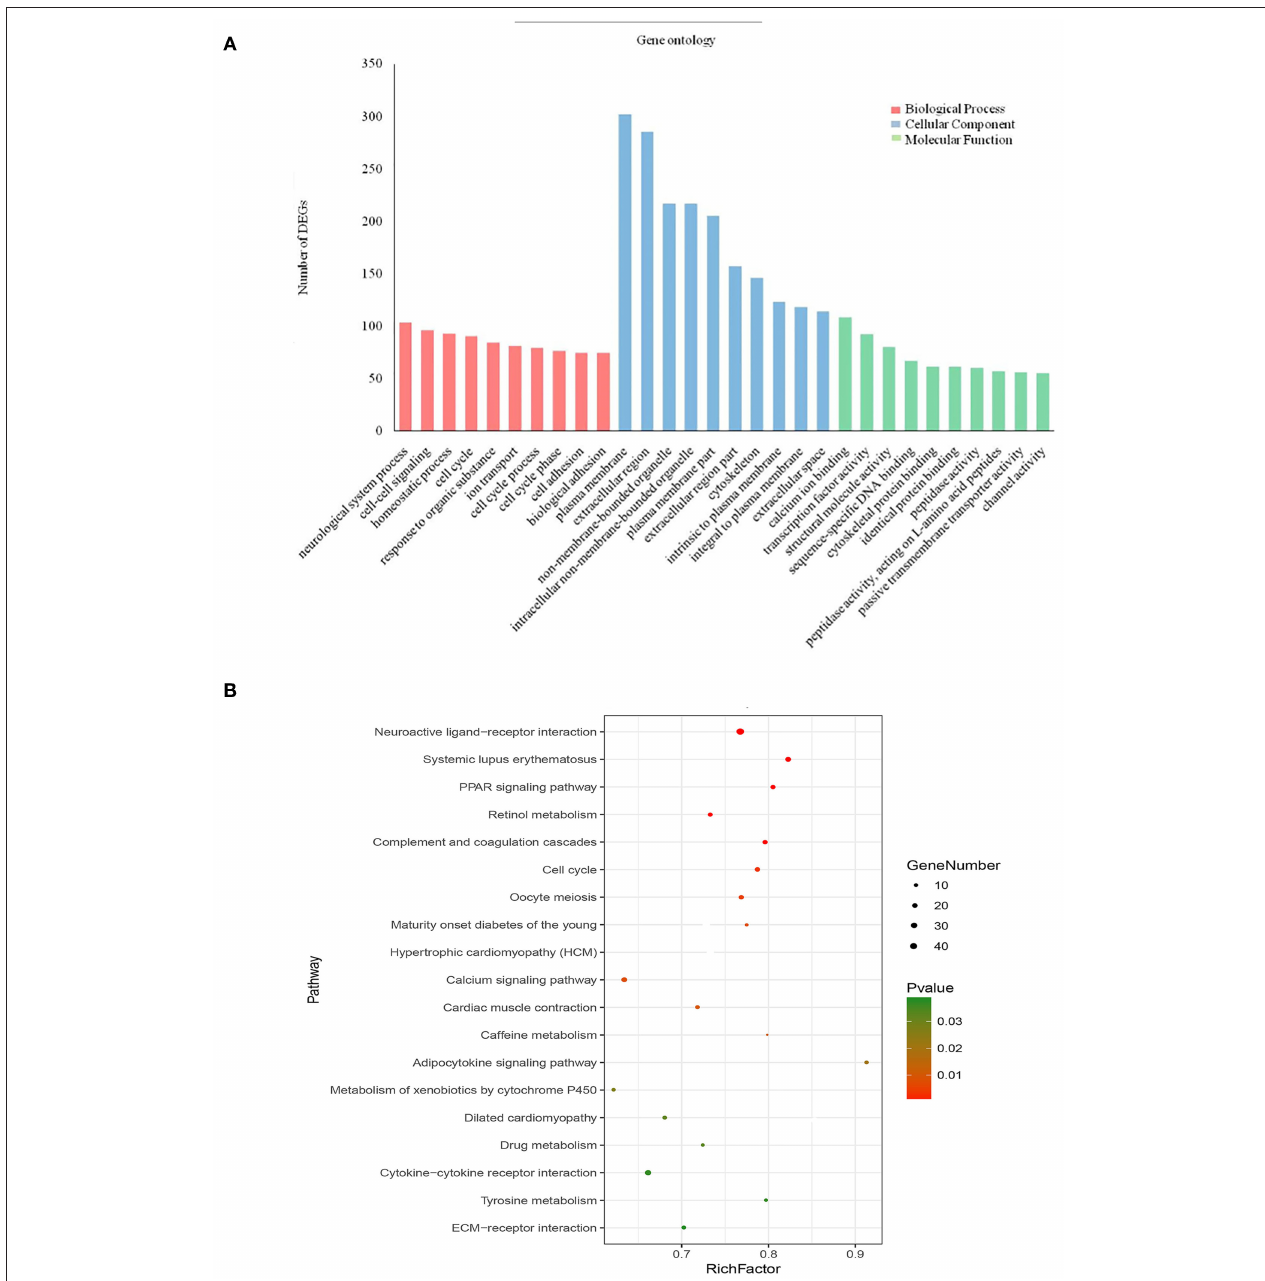
FIGURE 3 | Enrichment of gene ontology terms and KEGG pathways for DEGs. (A) Biological process, Cellular component and Molecular function for DEGs ( P < 0.05). (B) KEGG pathways for DEGs ( P < 0.05).